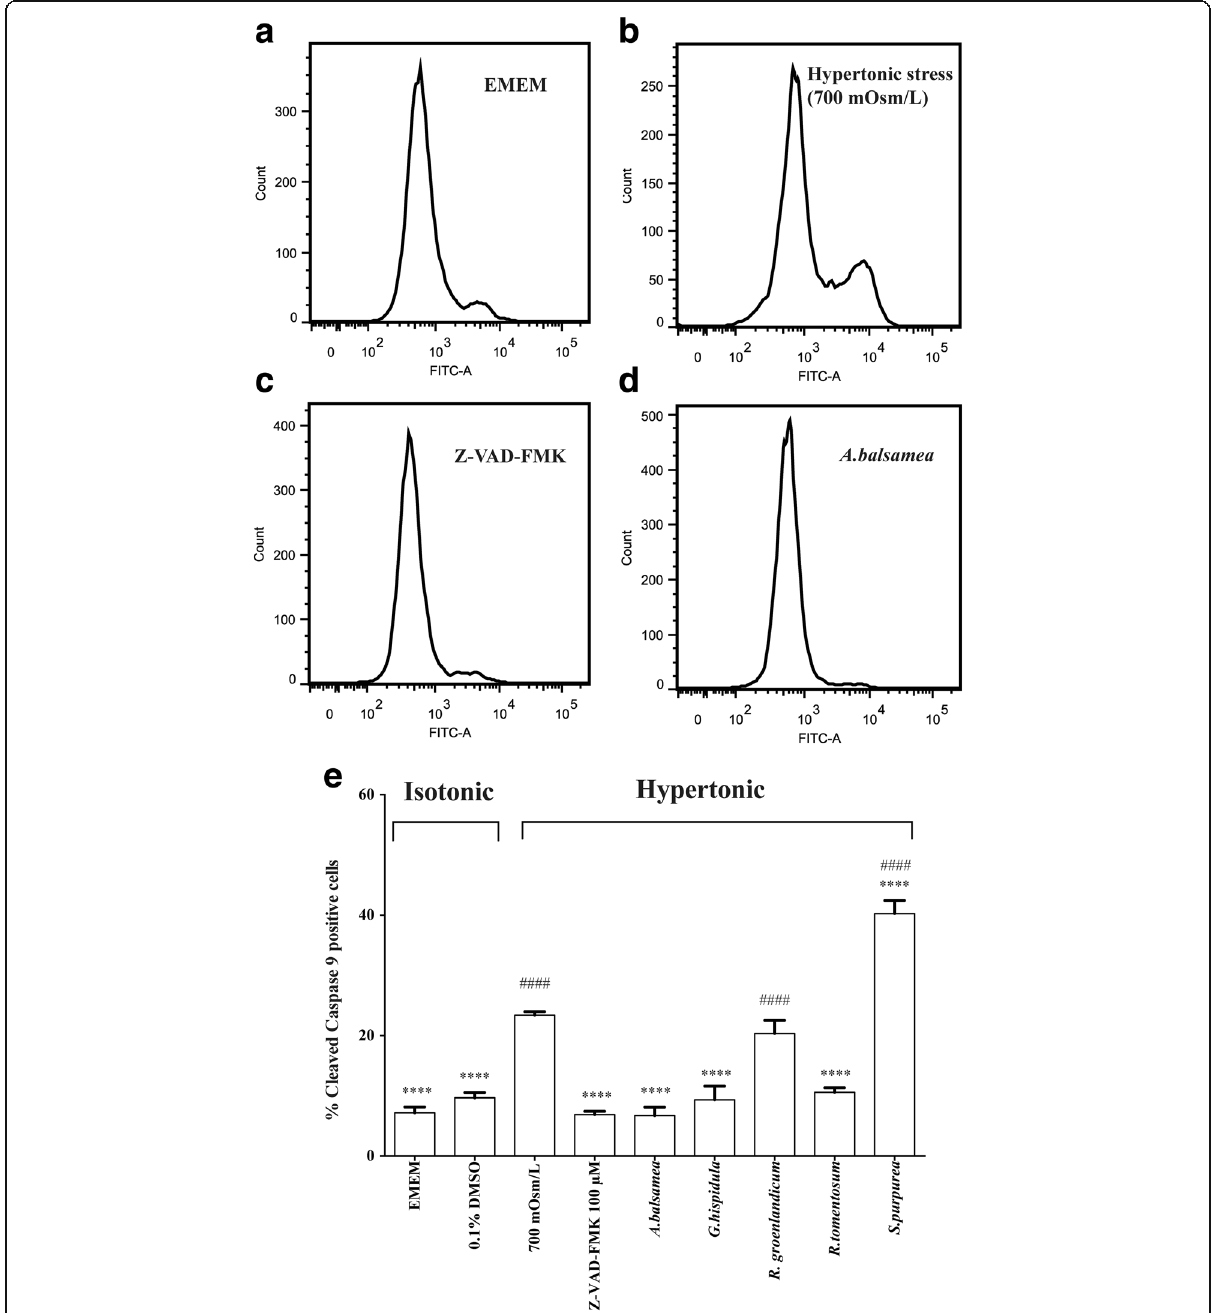
Fig. 4 Cleaved caspase 9 activity. Cleaved caspase 9 activity test was performed 18 h after the treatment with respective plant extracts. a - d Representative pictures of flow cytometry. Ordinate indicates cell count whereas abscissa represents fluorescence signal strength. From left to right, 1st peak indicates procaspase 9 and 2nd peak represents cleaved caspase 9 activity. e Histogram of percent cleaved caspase 9 positive cells. The percent cleaved caspase 9 activity was calculated as the area of 2nd peak/total area × 100. Results were expressed as means ± SEM for 3 separate experiments. * ( P < 0.05), **( P < 0.01), *** ( P < 0.001) and **** ( P < 0.0001) denotes other treatments significantly different from 700 mOsm/L hypertonic stress treatment, one-way ANOVA and Bonferroni test. ## ( P < 0.01), ### ( P < 0.001) and #### ( P < 0.0001) denotes treatment groups significantly different from isotonic EMEM, one-way ANOVA and Bonferroni